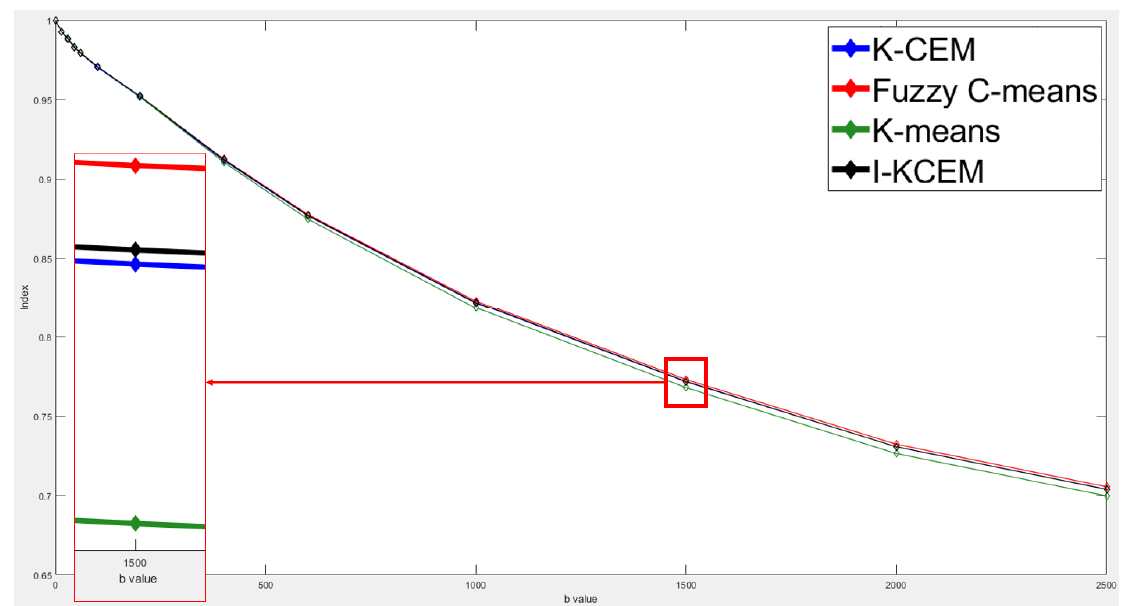
Figure 12. Signal-intensity decay of a non-mass tumor detected by the four methods using different b values in the 8th slice. Table 2. Results of applying different detection methods to a non-mass